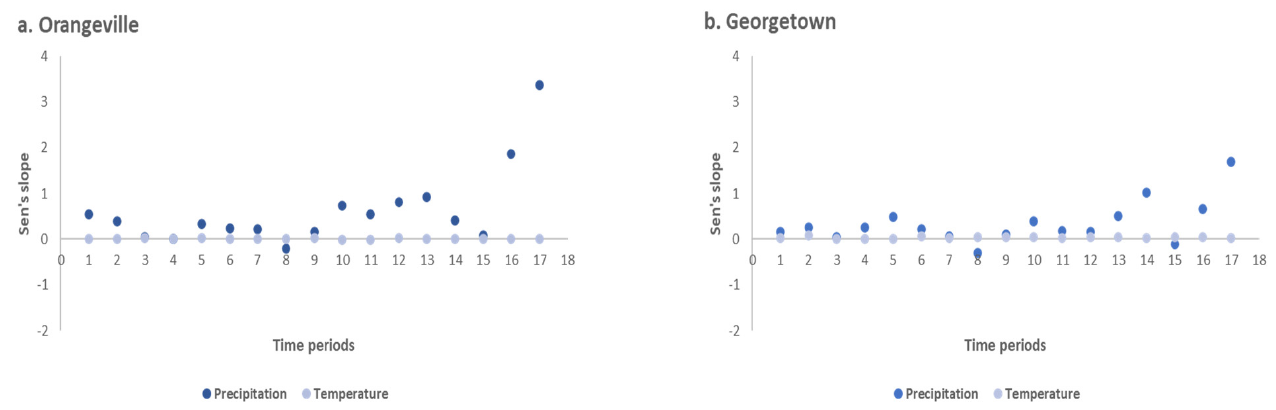
Figure 7. Sen’s slope values for precipitation and temperature for ( a ) Orangeville and ( b ) Georgetown for 12 months (1 to 12), winter (13), spring (14), summer (15), and autumn (16), and annually (17). The number in the bracket shows the time period in the x -axis.